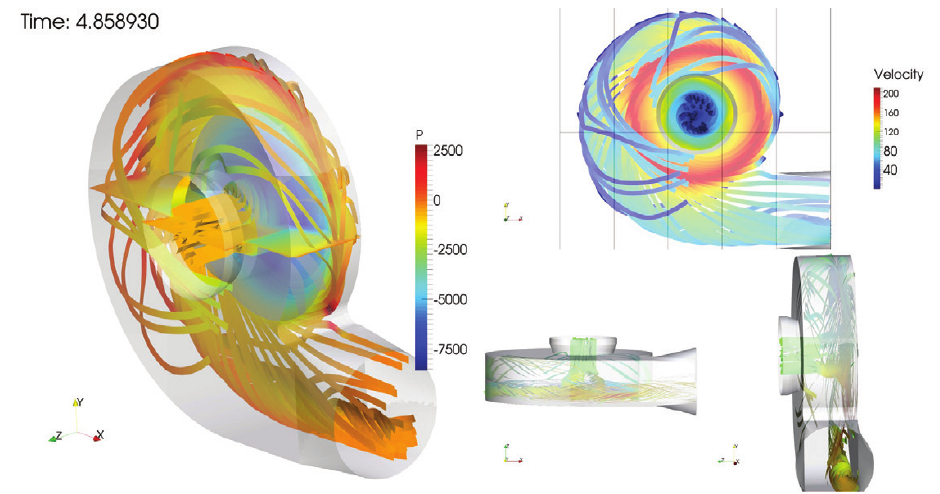
Figure 24 - Mean pressure and mean velocity fields magnitude.